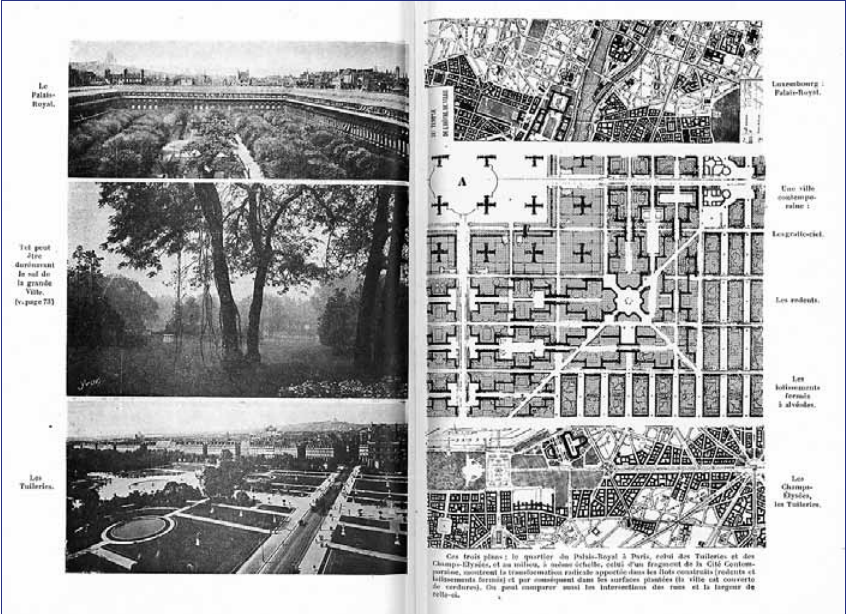
fig. 23. graphic comparison in Urbanisme . ©